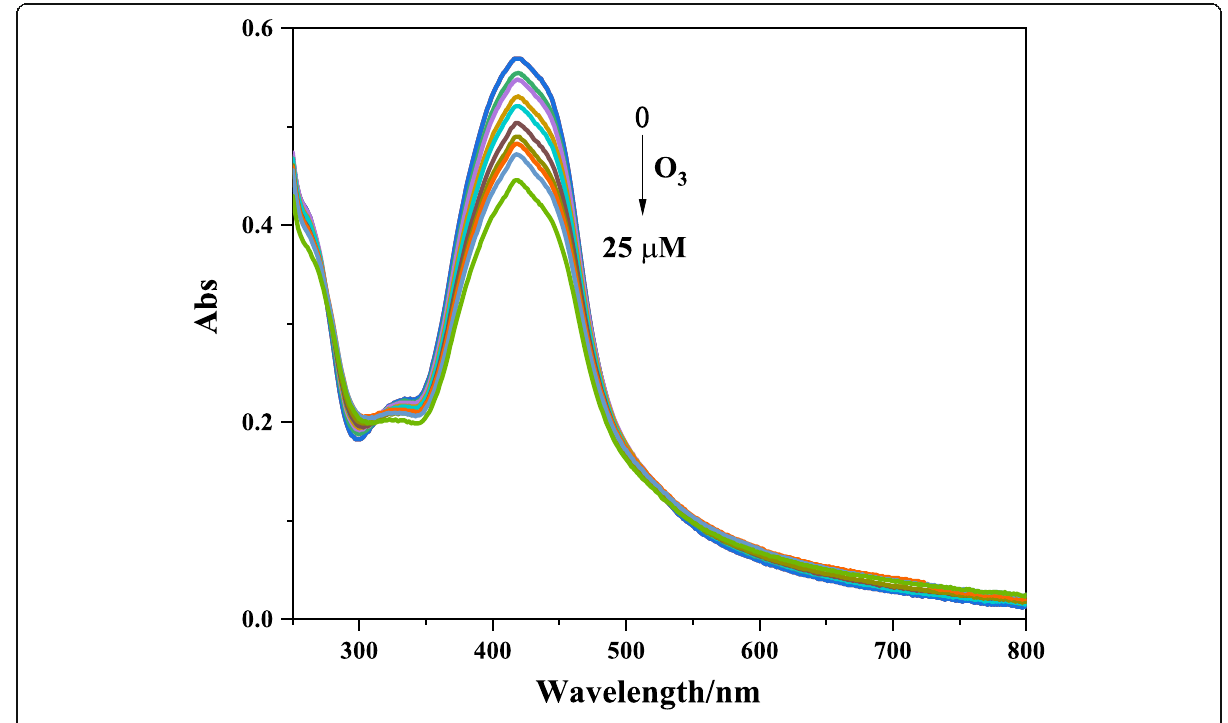
Fig. 1 Comparison of UV absorption before and after the reaction of BCT and O 3